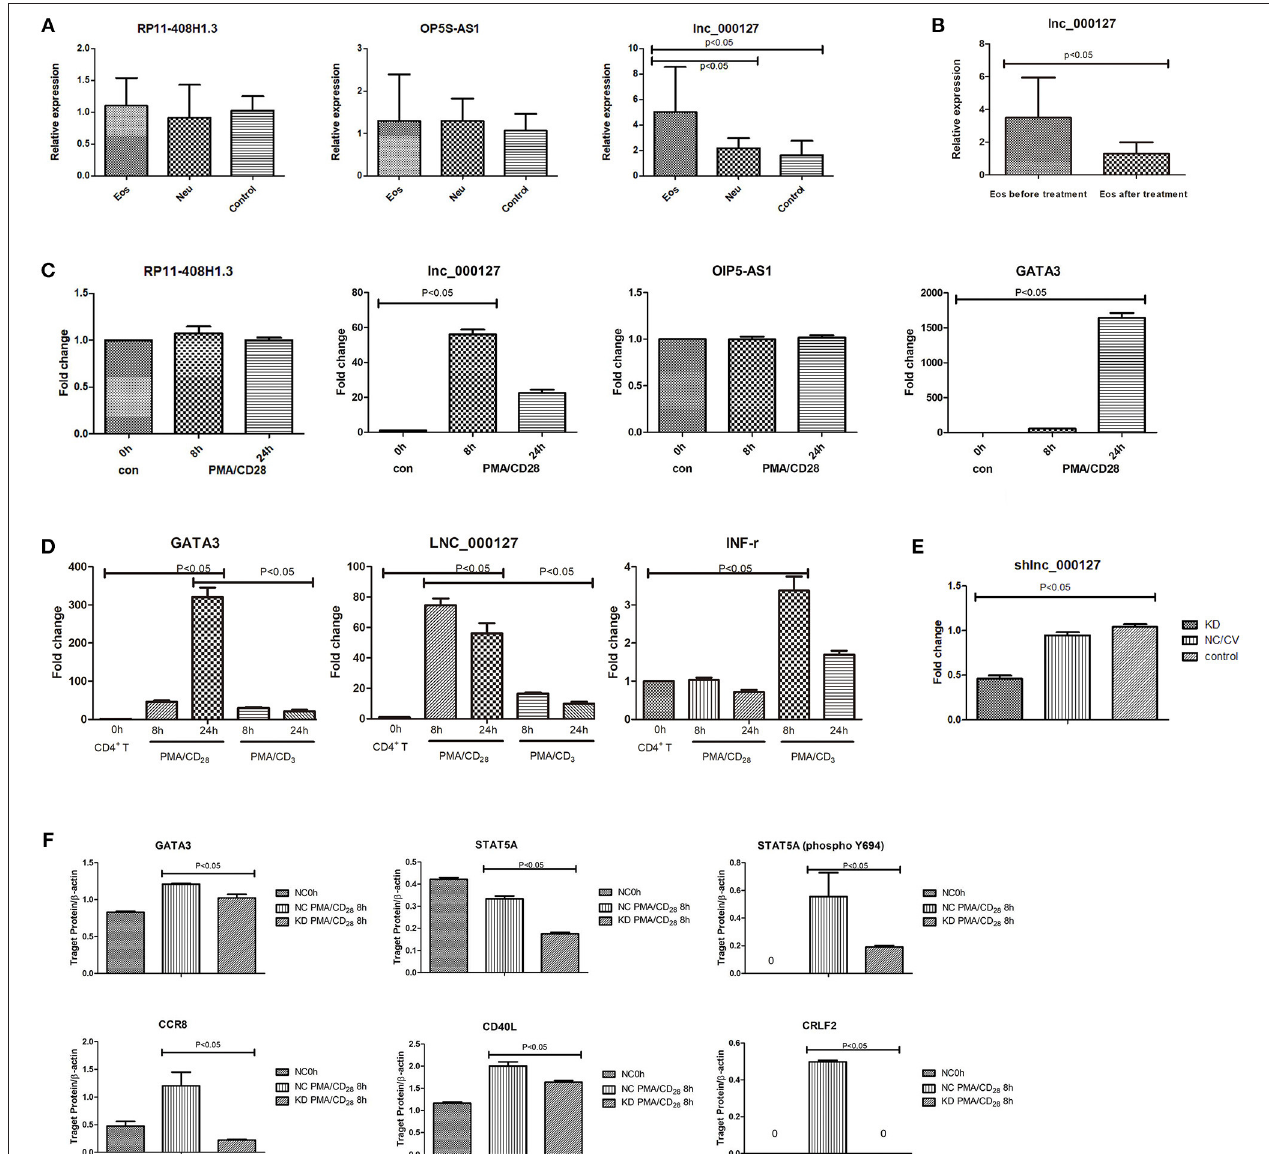
FIGURE 3 | (A) Three selected lncRNA expression levels were validated in vivo . The expression of the selected three lncRNAs was validated by qPCR in three groups in vivo . LNC_000127 was upregulated in Eos samples ( p < 0.05). (B) Before and after treatment, the expression of LNC_000127 was validated by qPCR in Eos samples in vivo . LNC_000127 was downregulated after treatment in Eos samples ( p < 0.05). (C) lncRNA expression in response to PMA/CD 28 stimulation. Jurkat cells were treated without (control) or with 10ng/mL PMA, and 1 µ g/mL CD 28 for 8 and 24h. Levels of selected lncRNAs and GATA3 were determined by qPCR, using the housekeeping gene GAPDH as a reference. Data are shown as the mean ± SD ( n = 3) and are representative of one of three independent experiments. p < 0.05 compared to the control group, as analyzed by one-way ANOVA and post-hoc Bonferroni test. (D) Human CD4 + T cells were divided into three groups. One group was treated with 10ng/mL PMA, and 1 µ g/mL CD 28 for 8 and 24h. One group was treated with 10ng/mL PMA, and 1 µ g/mL CD 3 for 8 and 24h. The last group was used as a control. Gene expression results were validated by qPCR. Levels of selected genes (GATA3, LNC_000127, and INF-r) were determined by real-time PCR using the housekeeping gene GAPDH as a reference. Data are shown as the mean ± SD ( n = 3) and are representative of one of three independent experiments. A p -value < 0.05 compared to the control group, as analyzed by one-way ANOVA and post-hoc Bonferroni test. (E) Expression of LNC_000127 was validated by qPCR. Data are shown as the mean ± SD ( n = 3) and are representative of one of three independent experiments. p -Value < 0.05 compared to the control group, as analyzed by one-way ANOVA and post-hoc Bonferroni test. (F) Expression of the genes was validated by western blotting. Gene expression in response to PMA/CD 28 stimulation. Jurkat cells were treated without (control) or with 10ng/mL PMA, and 1 µ g/mL CD 28 for 8h. β -Actin was used as a reference. The relative abundance of genes was calculated as the ratio of the normalized densitometric values between three samples. Intergroup differences (of the densitometry data) were calculated by the Mann-Whitney U test using SPSS version 11.6 software. p -Value < 0.05 was considered to indicate a statistically significant difference.